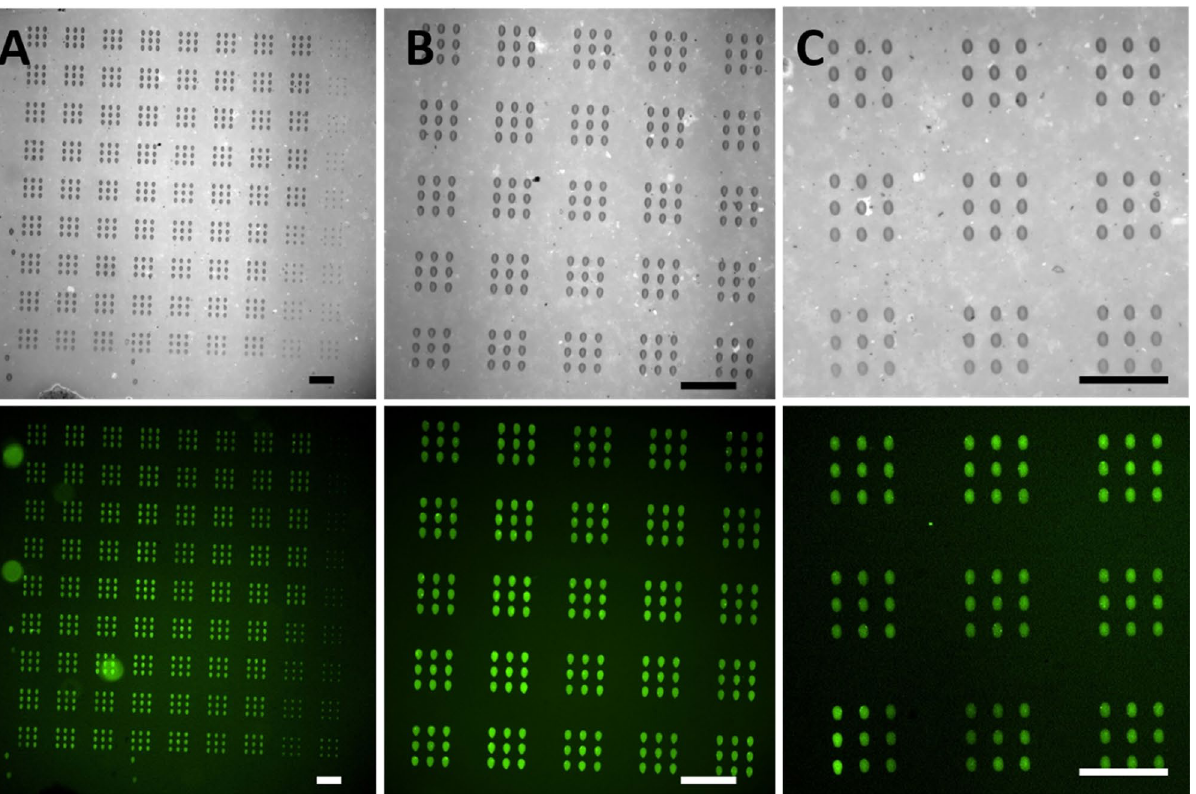
Figure 3. Protein microarrays on GO coatings. ( A ) Bright field and corresponding fluorescence image of a 729 features fibronectin microarray (9 × 9 feature subunits in a 9 × 9 array over an area of 1260 × 1260 µm 2 ). ( B ) Subset of the microarray in ( A ). ( C ) Small-area 3 × 3 array of similar subunits in bright field and in fluorescence. All images were taken prior to washing step (to obtain visibility in bright field), scale bars equal 100